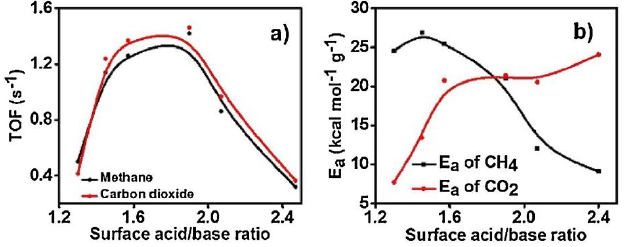
Figure 1. Variation of ( a ) turnover frequency (TOF) with acid/base ratio and ( b ) activation energy with acid/base ratio. Reproduced with permission from [10].